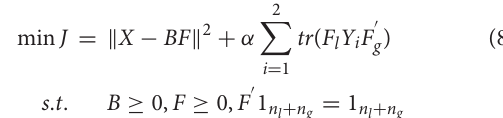
Frontiers in Genetics |